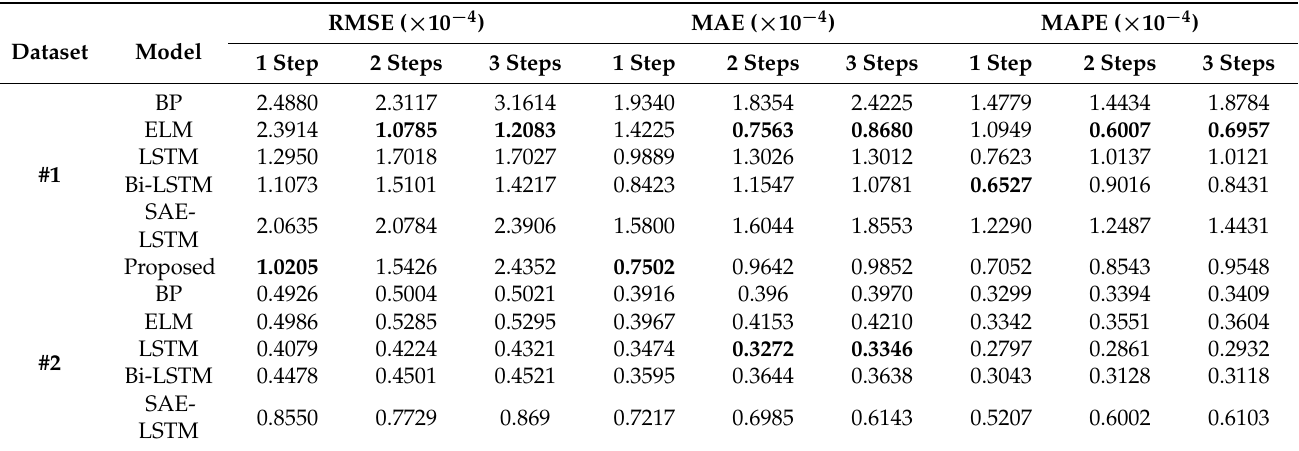
Table 7. The pitch angle prediction errors of different